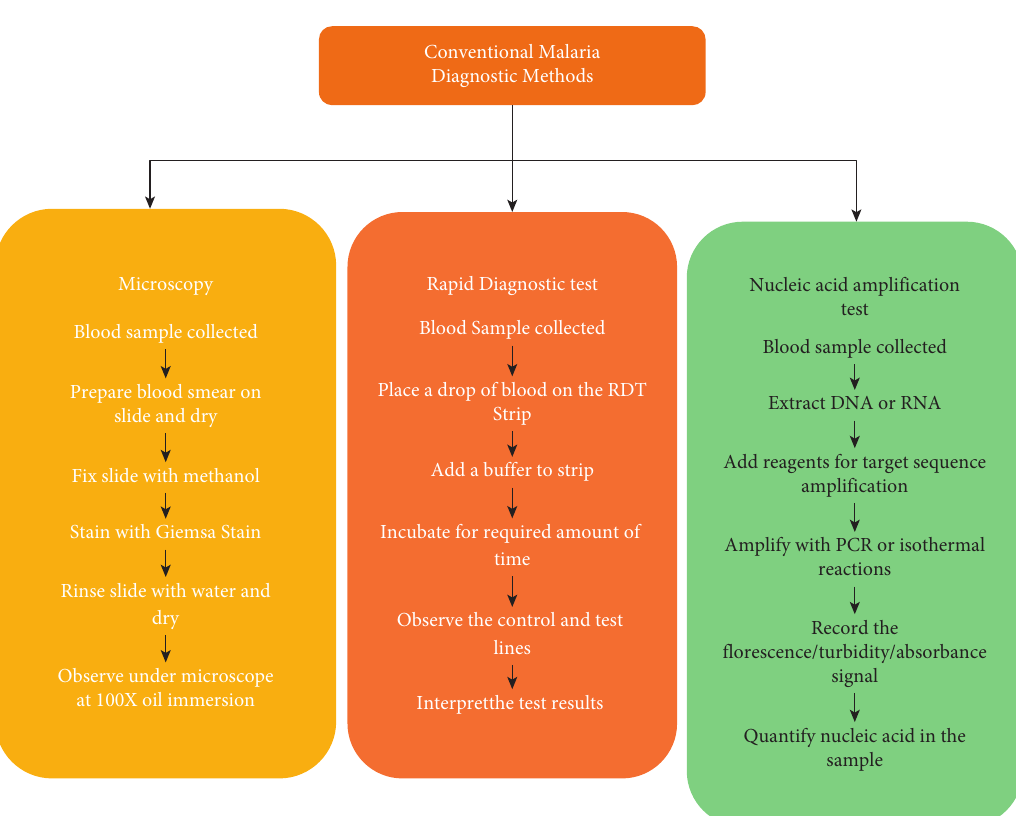
Figure 1: Diagrammatic illustration of the diagnostic tools currently in use